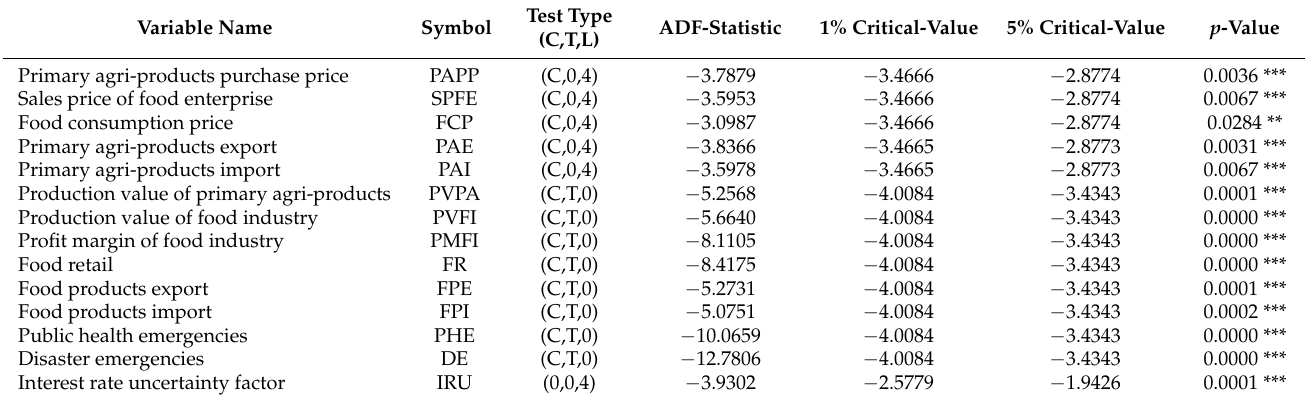
Table 2. Unit root